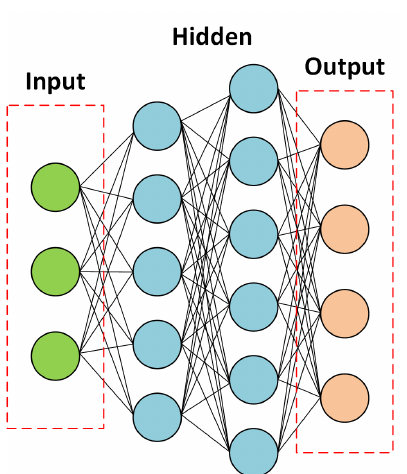
Figure 18. An illustration of a fully connected neural